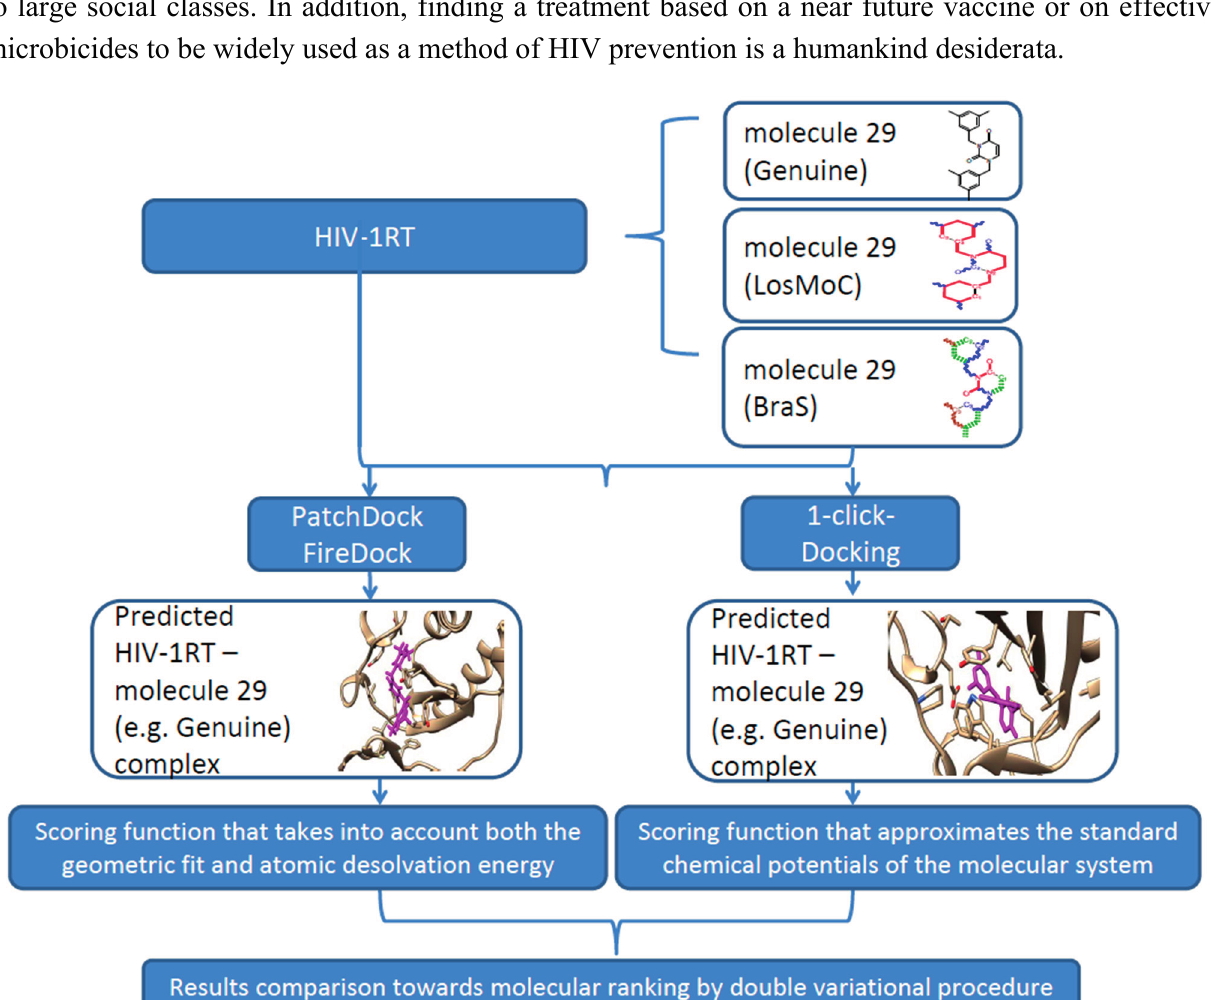
Figure 6. Flow diagram summary outlining the computational protocol towards double variational procedure in the relevant configuration(s) for the present outlined molecule 29; See text for